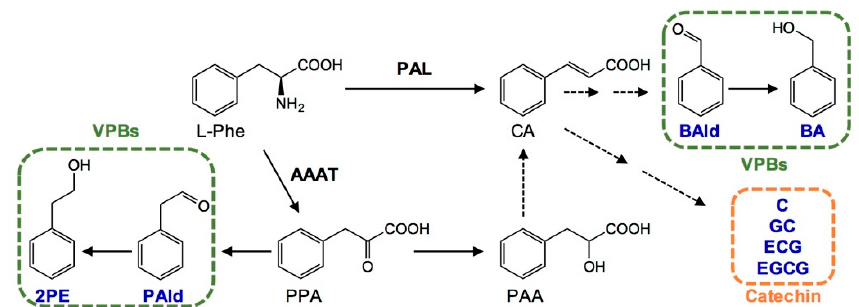
Figure 4. The metabolic pathway of L -phenylalanine in tea leaves. L -Phe: L -phenylalanine; VPBs: volatile phenylpropanoids/benzenoids; BAld: benzaldehyde; BA: benzyl alcohol; CA: